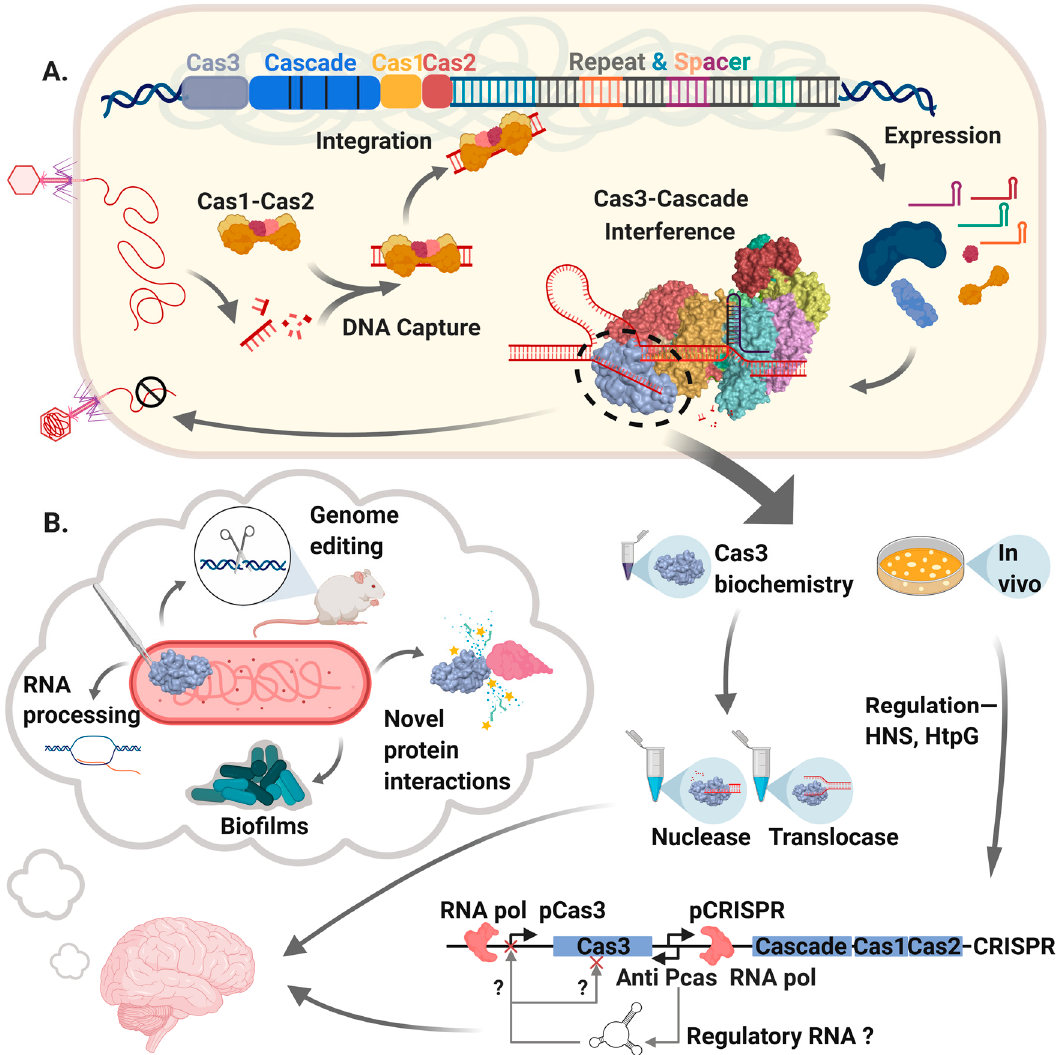
Figure 1. A summary of Cas3 as covered in this review. A. The main events in CRISPR-Cas